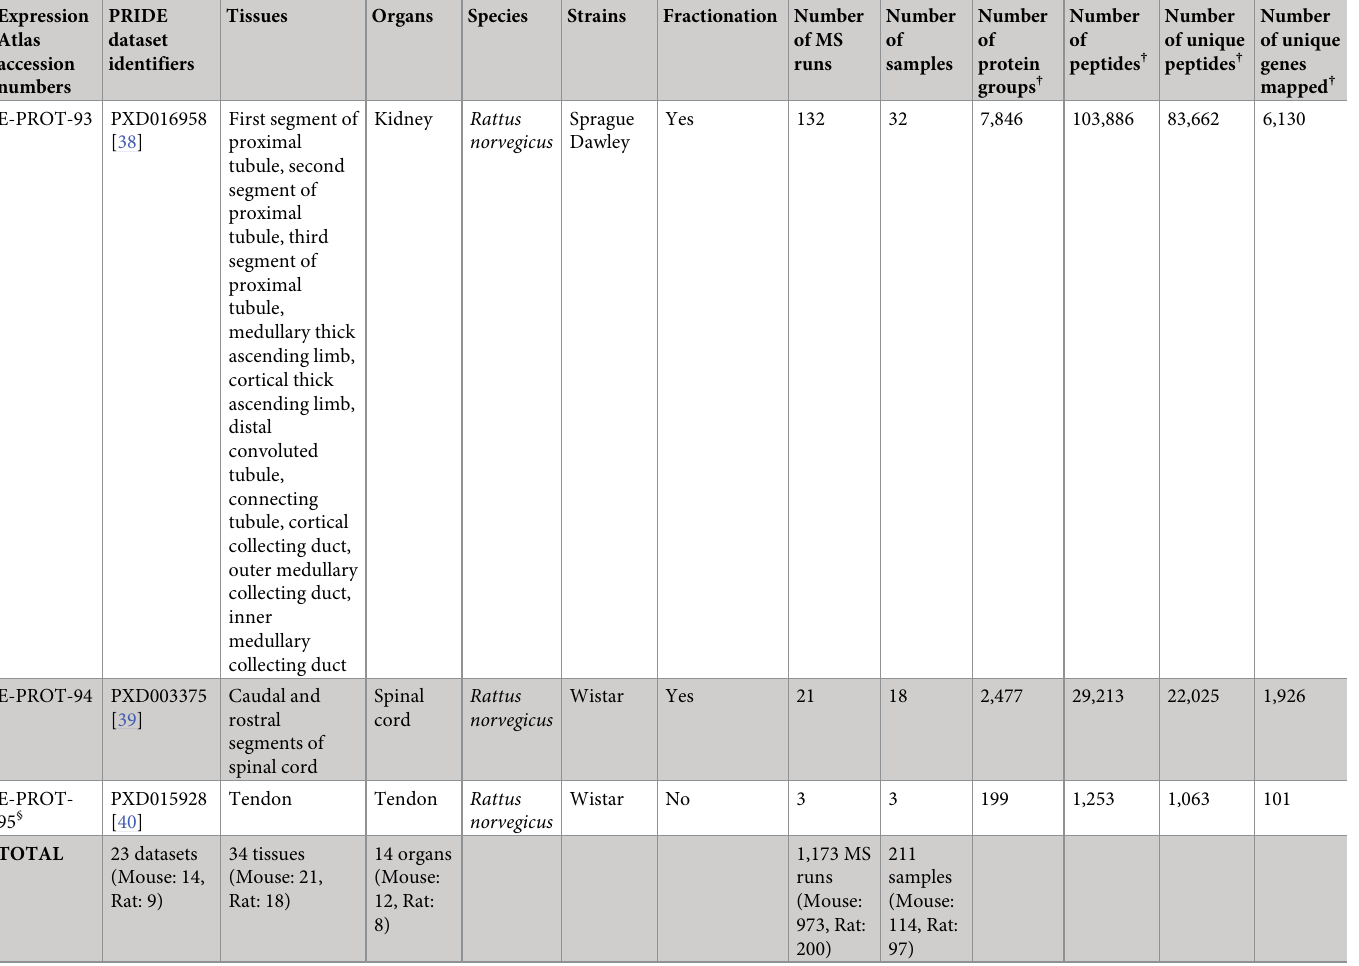
taken with caution since the list is subjected to inflated False Discovery Rate (FDR), due to the accumulation of false positives when analysing the datasets separately. Some of the organs (liver, heart and brain) were represented across multiple mouse studies in the aggregated dataset. A pairwise comparison of protein abundances in these organs gener- ally showed a good correlation in expression (heart: R 2 values ranged from 0.54 to 0.83; brain: R 2 from 0.28 to 0.72; and liver: R 2 from 0.59 to 0.74) (Figs A-C in S4 File). 2.2.2. Rat proteome. A total of 7,769 protein groups were identified across 8 different rat organs among which 3,649 (46.9%) protein groups were unique to one specific organ while 13 (0.16%) protein groups were present among all organs (see full list in S2 File). The protein groups were mapped to 7,116 genes (canonical proteins) (S3 File). The highest number of canonical proteins (6,106, 85.1%) was found in rat kidney samples. The lowest number of canonical proteins (101, 1.4%) was found in samples from tendon, as shown in Fig 3A. The largest number of canonical proteins identified in kidney is likely because of the